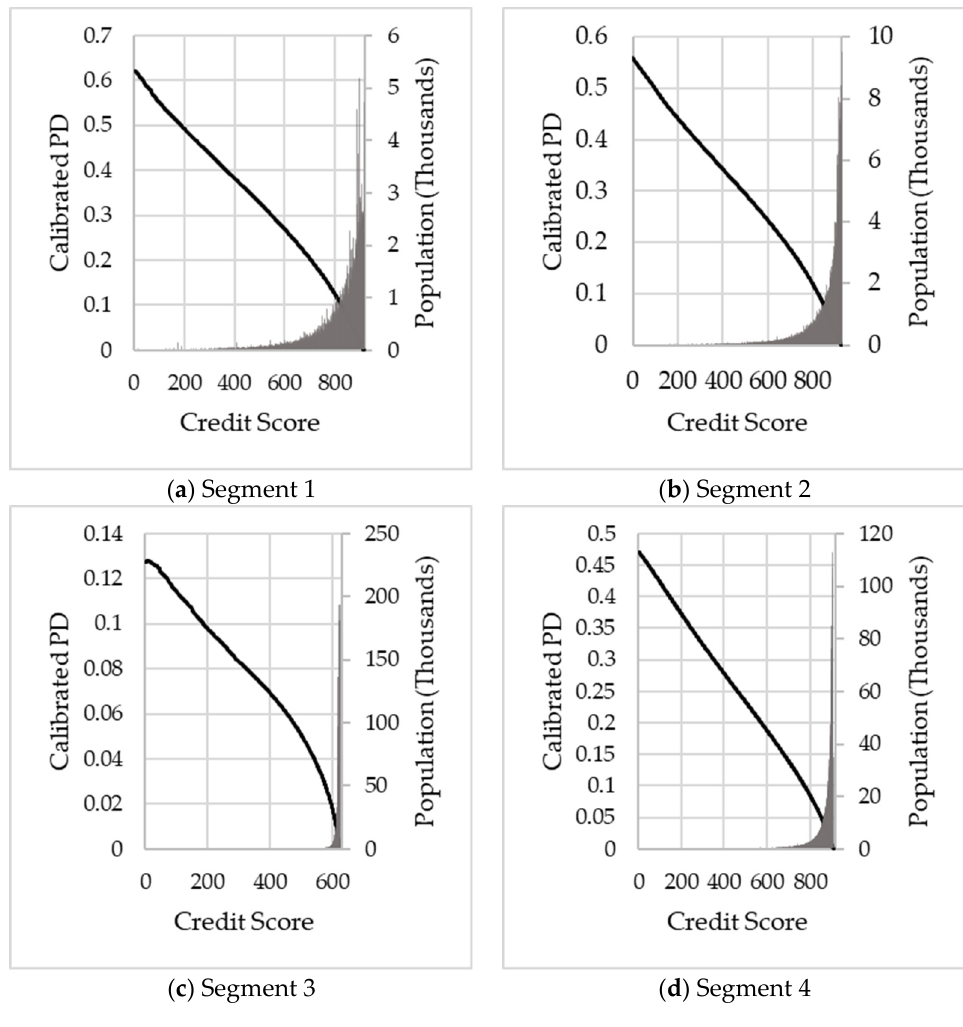
Figure 7. 12 month calibrated PD by score. Figure 7 . 12 month calibrated PD by score. Table 6. 22 month Lorenz curve calibration